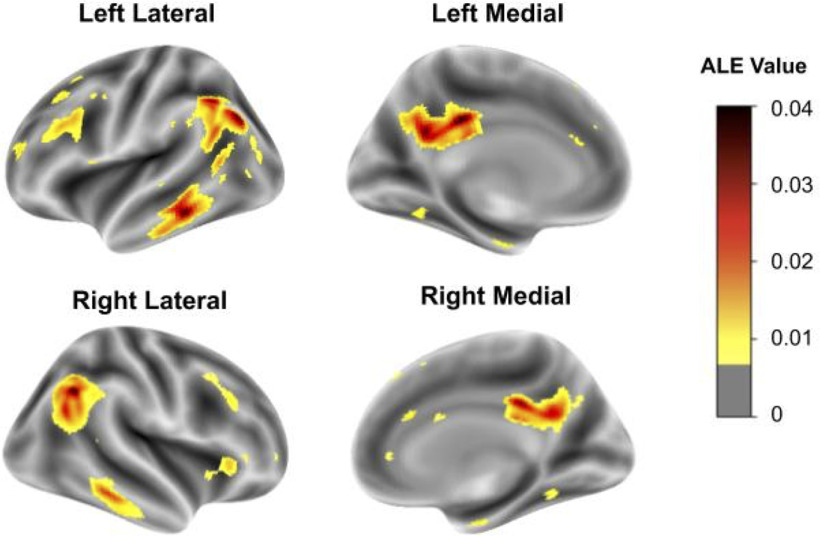
 Cortical surface views of the ALE meta-analysis results. Regions where hypometabolism was not detected are transparent (ALE value of 0.006 or less). Lower glucose utilization (AD vs controls) ranges from low (yellow) to high (black).